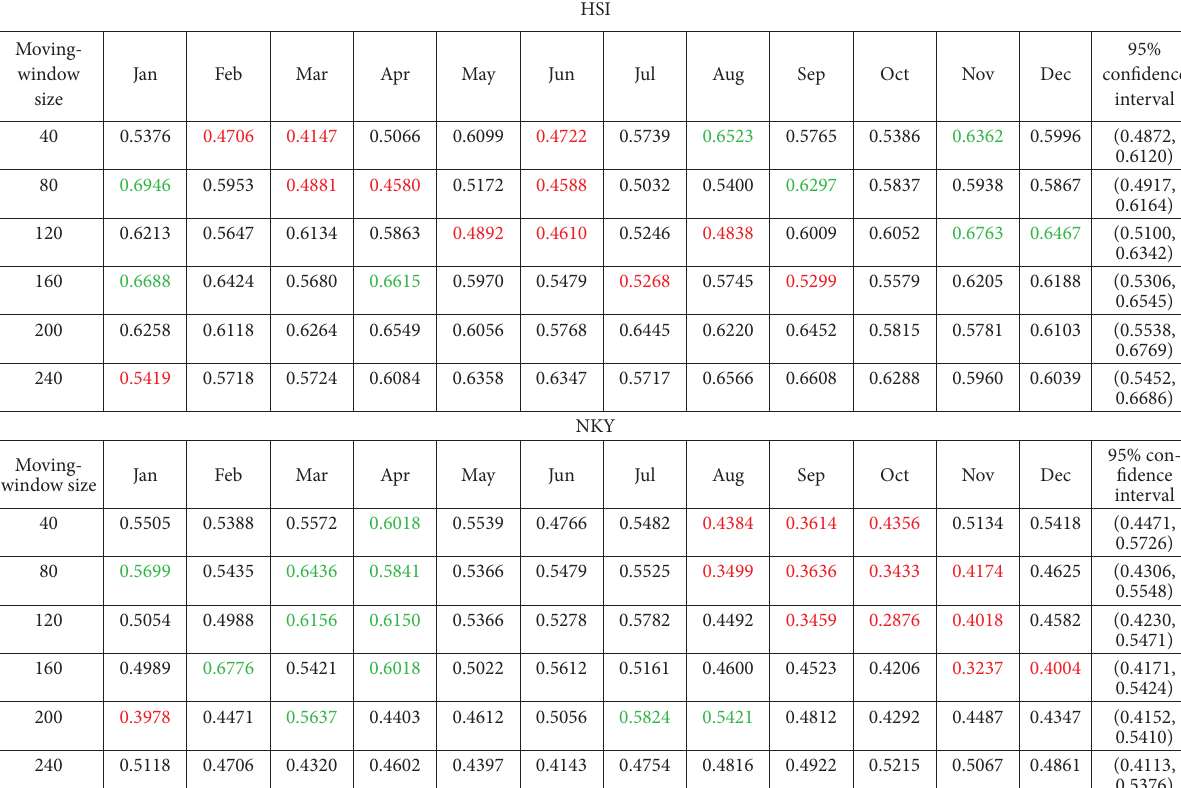
Table 5. The test results for the overall calendar effect using Method